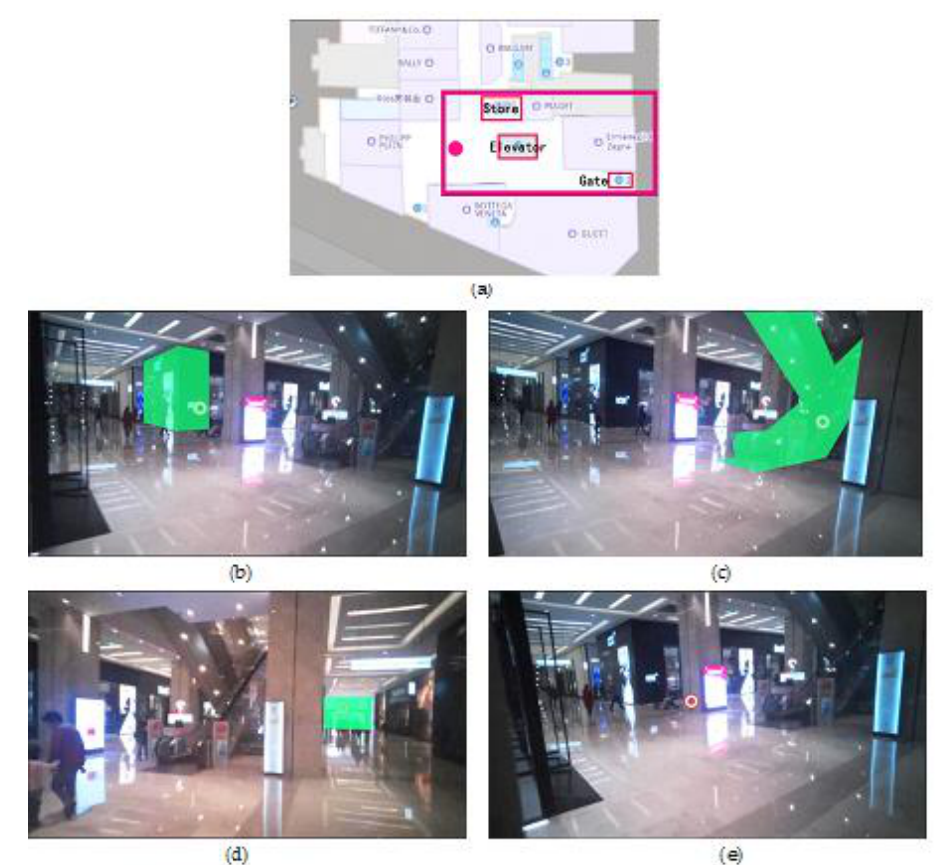
Figure 5. Experiment position and AOI divisions: ( a ) Experiment position and participant’s visual field in AOIs, ( b ) AOI of store, ( c ) AOI of elevator, ( d ) AOI of the gate, and ( e ) AOI of others.